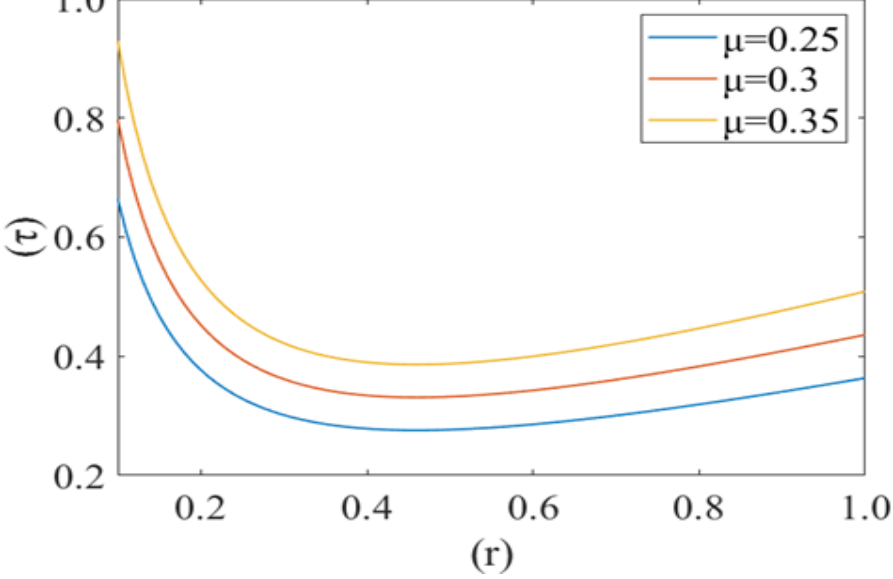
Figure 11. Variation of the drag force ( τ ) at the rim of the cell with respect to its radius ( r ) with variation in viscosity ( µ ) with Re = 0.25, P1 = 2, k =